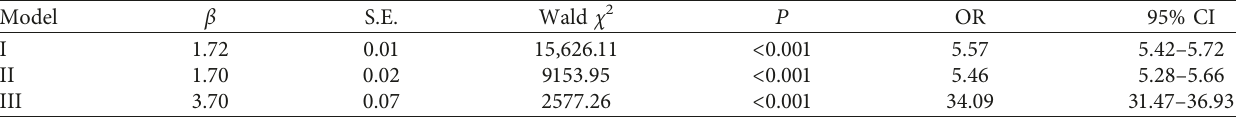
Table 4: The relationship between TyG index and MS across the three